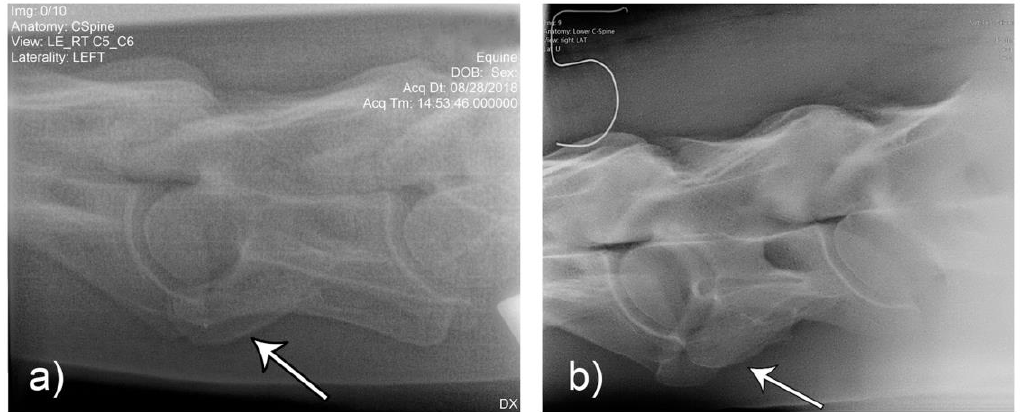
Figure 10. Laterolateral images F1 ( a ) and M2 ( b ) represent the malformation presentations of ECCMV: Unilateral (F1) and bilateral with (variable) bilateral transposition onto C7 (M2). Arrows indicate the abnormal line of the lamina in the absence of the caudal lamina of the transverse process.